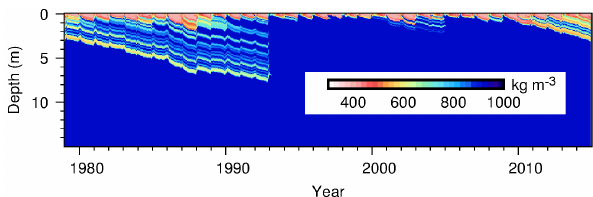
Figure 6. Time evolution of firn density as a function of depth for Cabinet Inlet, predicted by the firn density model (Ligtenberg et al.,